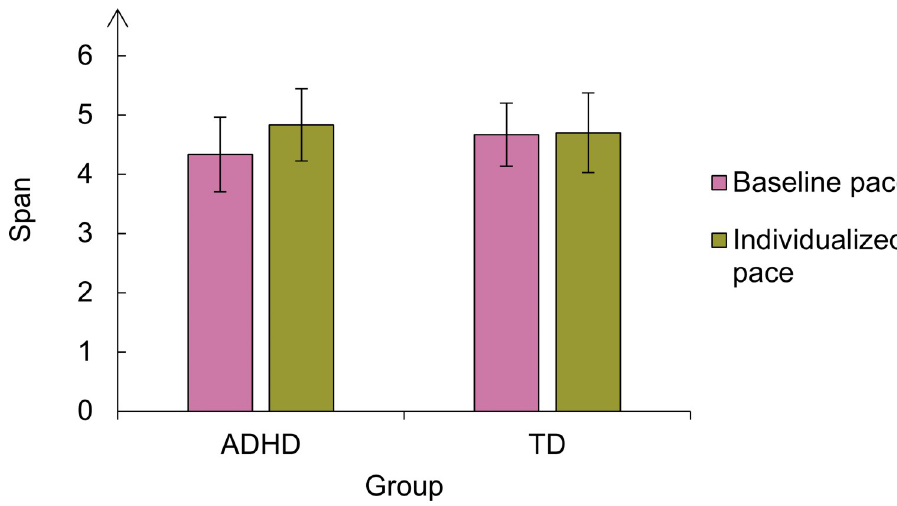
Fig 6. Mean spans per group and condition in Experiment 2. The vertical lines represent the confidence